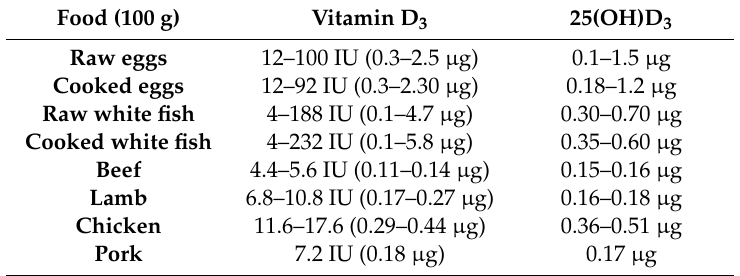
Table 2. Vitamin D 3 and 25(OH)D 3 content of chosen foods, modified by [94,95].